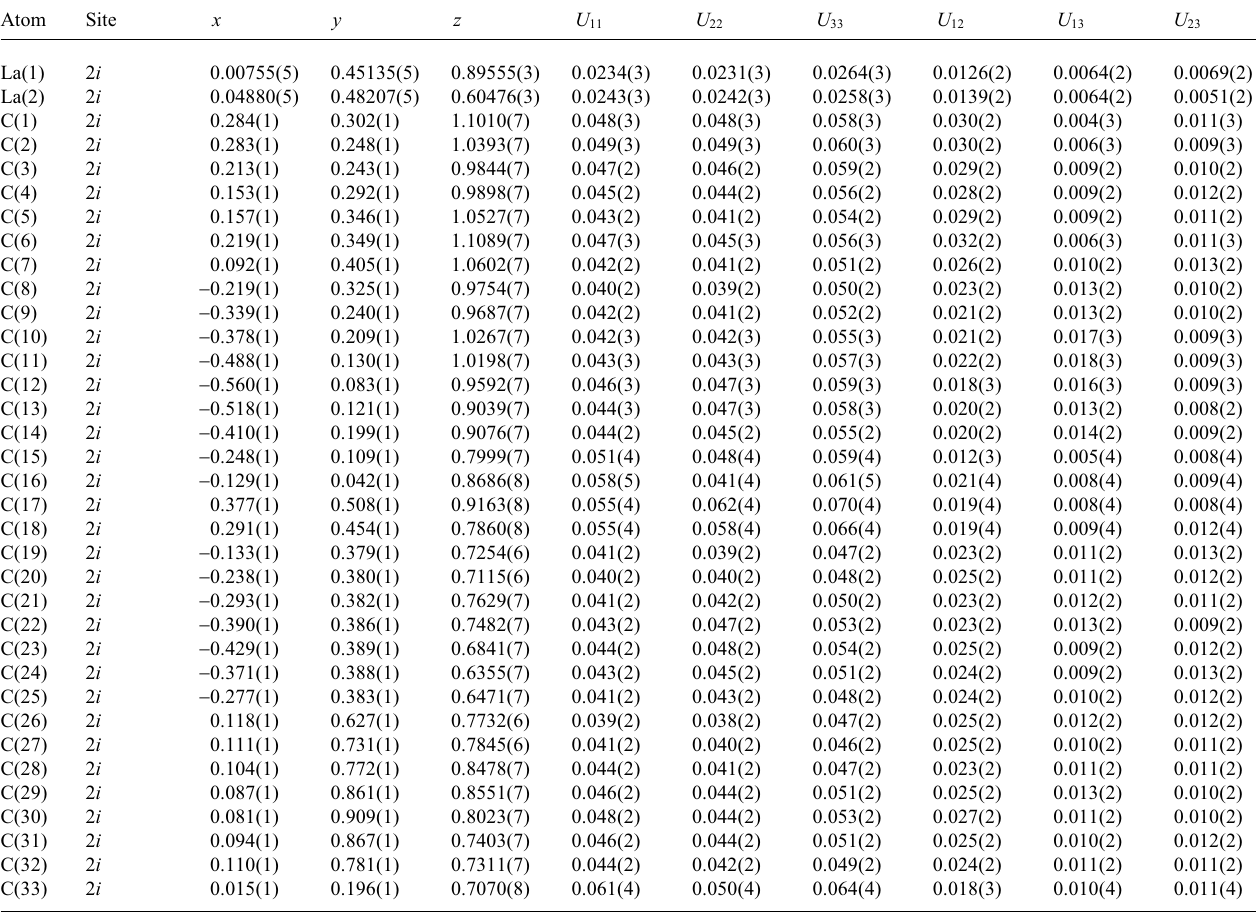
Table 3. Atomic coordinates and displacement parameters (in Å 2 ).